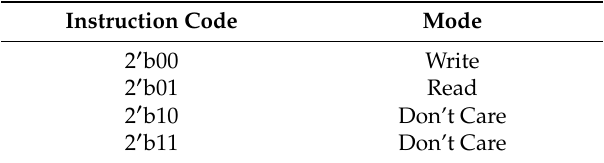
Table 1. The low-cost 3-wire SPI protocol design instruction code.